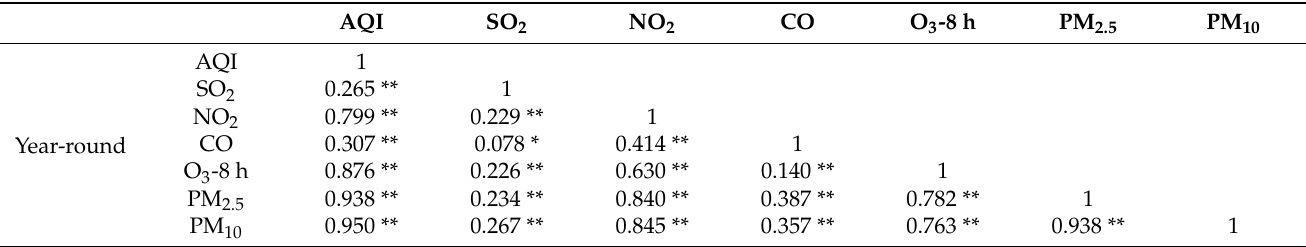
Table 5. Pollutant correlation